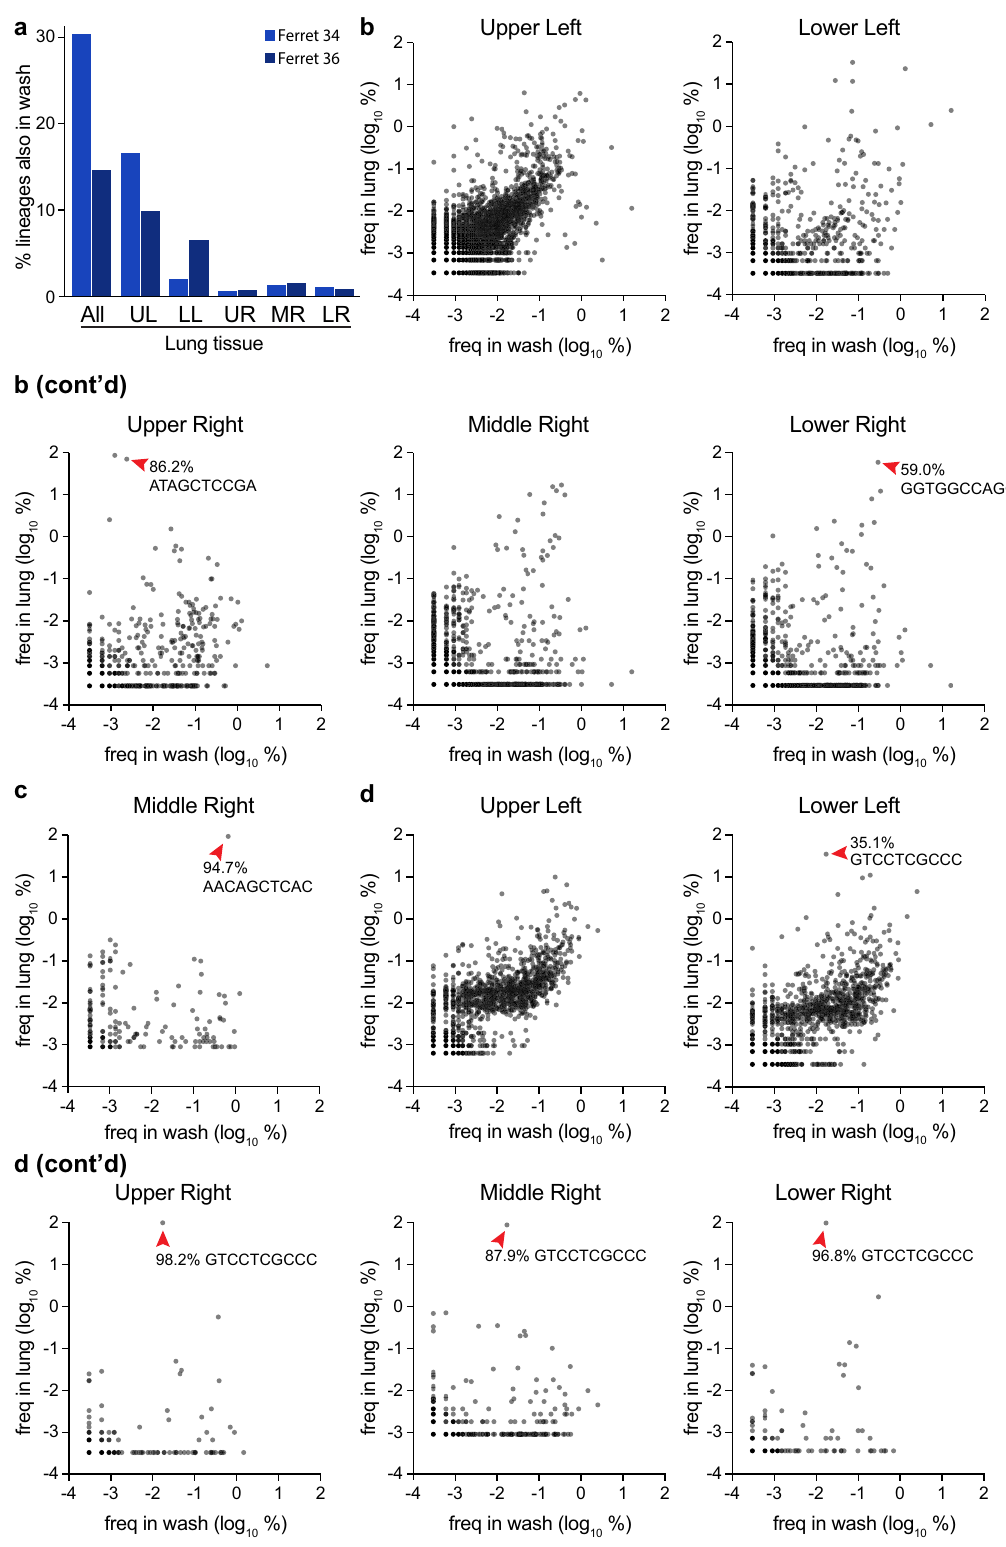
Fig. 7 Compartmentalized infections establish replication islands within the lung. a Overlap between barcodes in the nasal wash 3 dpi and those present in distinct lobes, or composite data for all barcodes in the lung. b – d The frequency of barcodes within the nasal wash is compared to frequencies within individual lobes for b ferret 34, c ferret 35, and d ferret 36. Red arrowheads highlight dominant barcodes with frequency >30%, which for ferret 36 is the same barcode that dominated in multiple lobes of the lung. Note that barcodes unique to the nasal wash or lung are not plotted here and can be found in Supplemental Fig. 6. Source data are provided as a Source Data fi